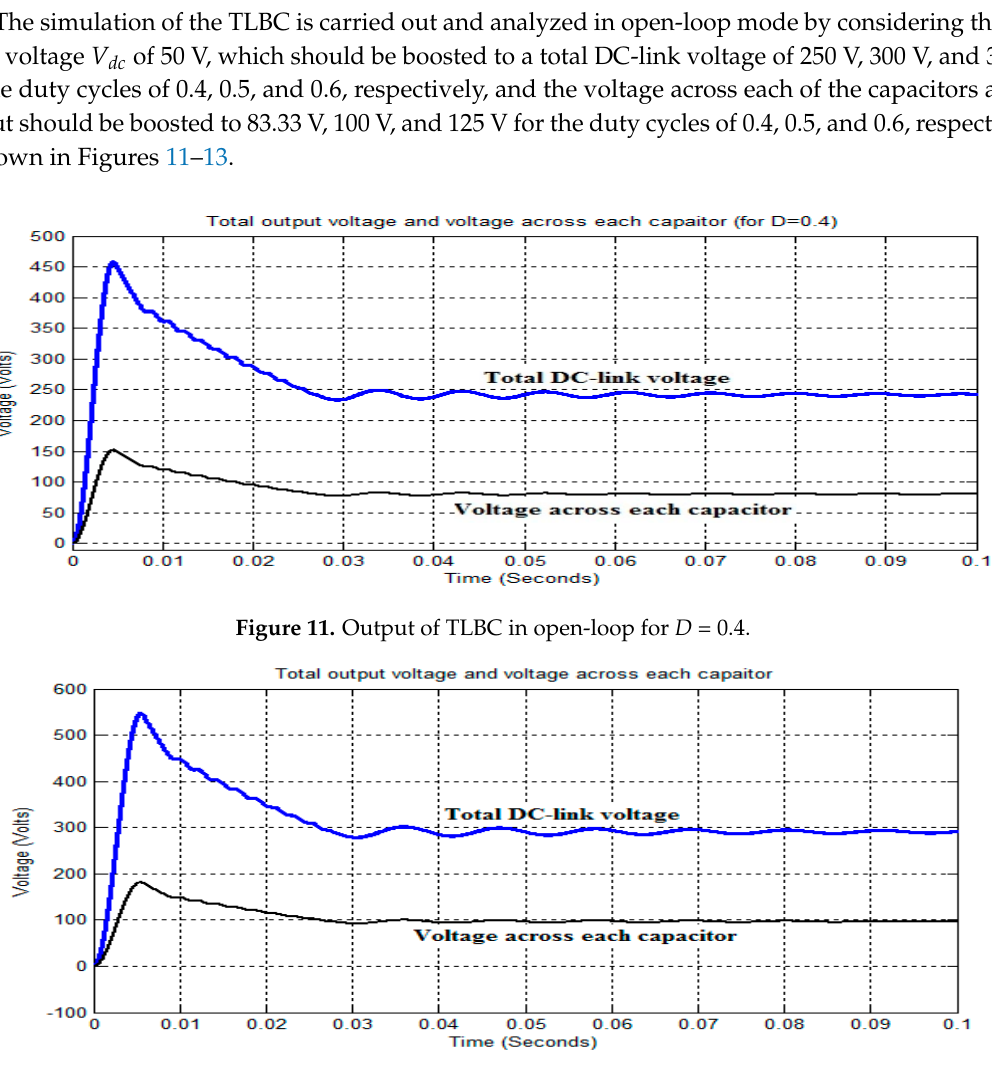
Figure 12. Output of TLBC in open-loop for D = 0.5.